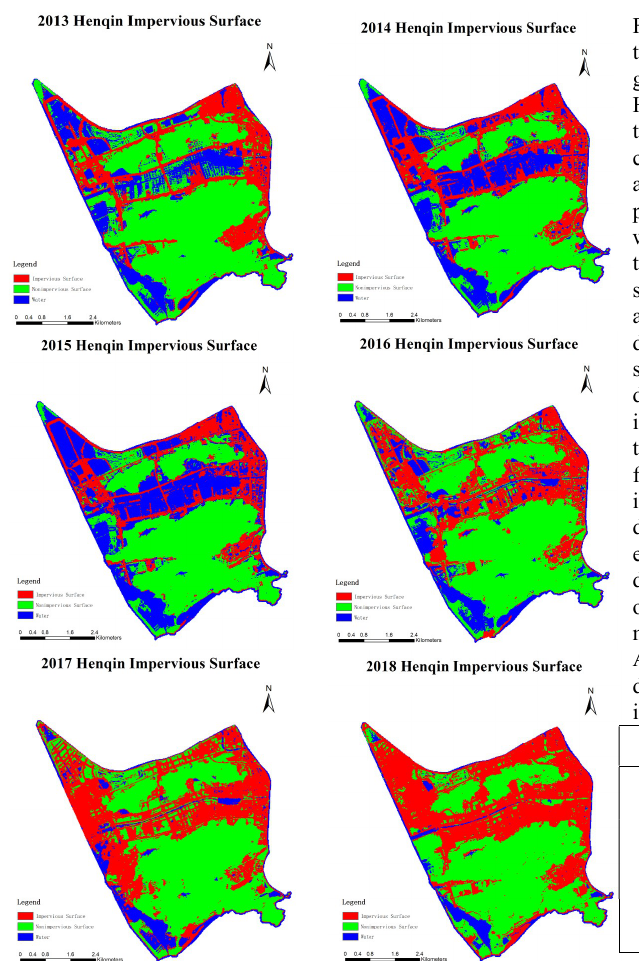
Table 2. The percentage of land cover in Hengqin area from 2013 to 2018 Figure 4. The change rate of land use percentage in Hengqin New Area